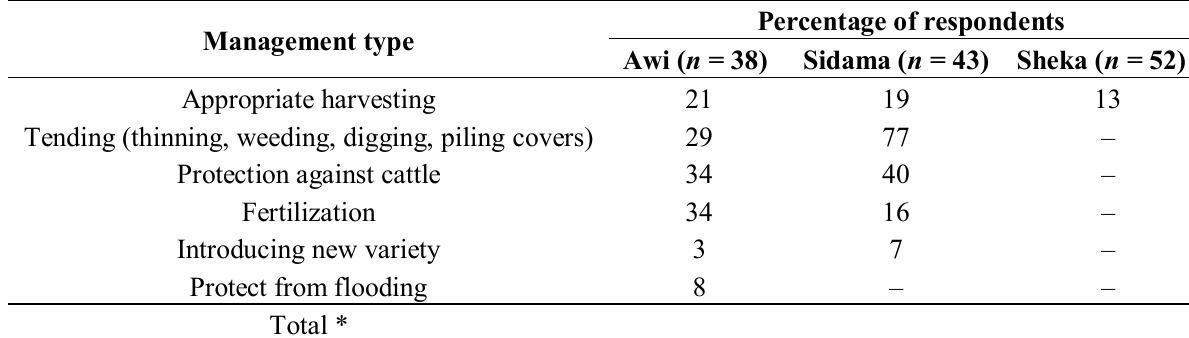
Table 1. Bamboo management practices in Awi, Sidama, and Sheka districts of